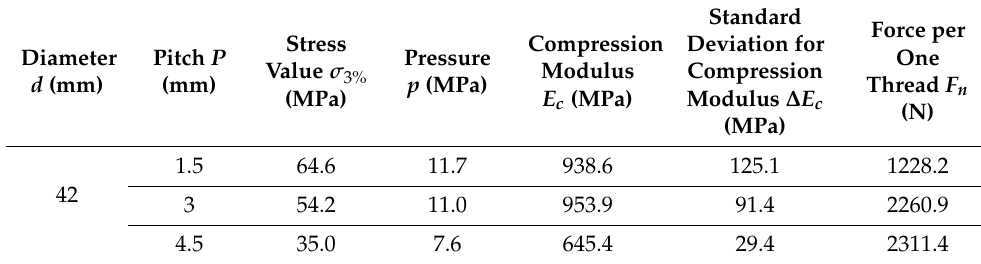
Table A1. Values determined in a static compression